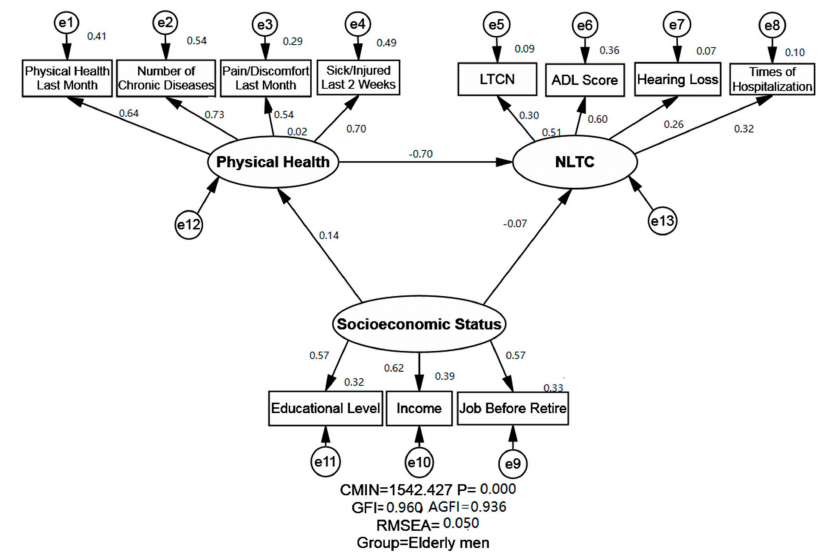
Figure 1. Structural equation modeling analysis of the association between socioeconomic status (SES), physical health and need for long-term care (NLTC) of the elderly men ( n = 7070). Employing the cross-sectionaldata, associationbetweenSES,physicalhealthandNLTCwereanalyzed. Arrowsindicate the associations and directions between variables, double curved arrows indicate correlation between each factor. All parameter estimates were statistically significant ( p < 0.001). Note: χ 2 = Chi square; GFI = Goodness of Fit Index; AGFI = Adjusted Goodness of Fit Index; RMSEA = Root-mean Square Error of Approximation; LTCN = Long-term Care Needs; SES = Socioeconomic Status; NLTC = Need for Long-term Care; CMIN: Chi-square value in Amos is called CMIN.